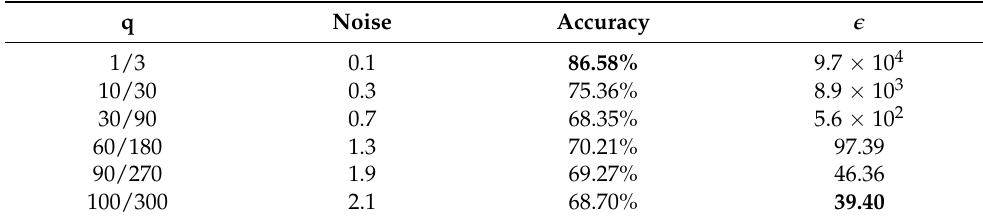
Figure 19. The robustness of differential privacy on chest X-ray images. Table 11. The summary table of the robustness of differential privacy on chest X-ray images.